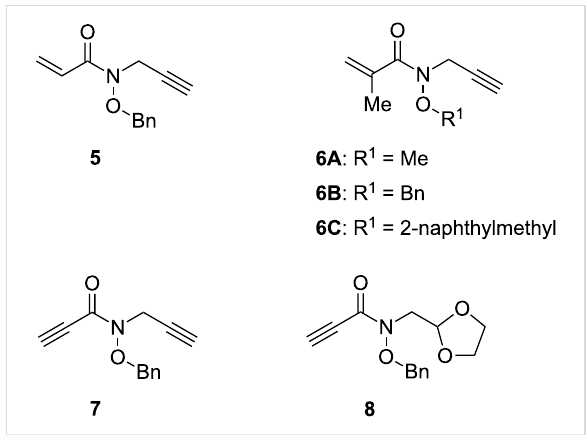
Figure 3: Substrates for testing the cascade transformation.